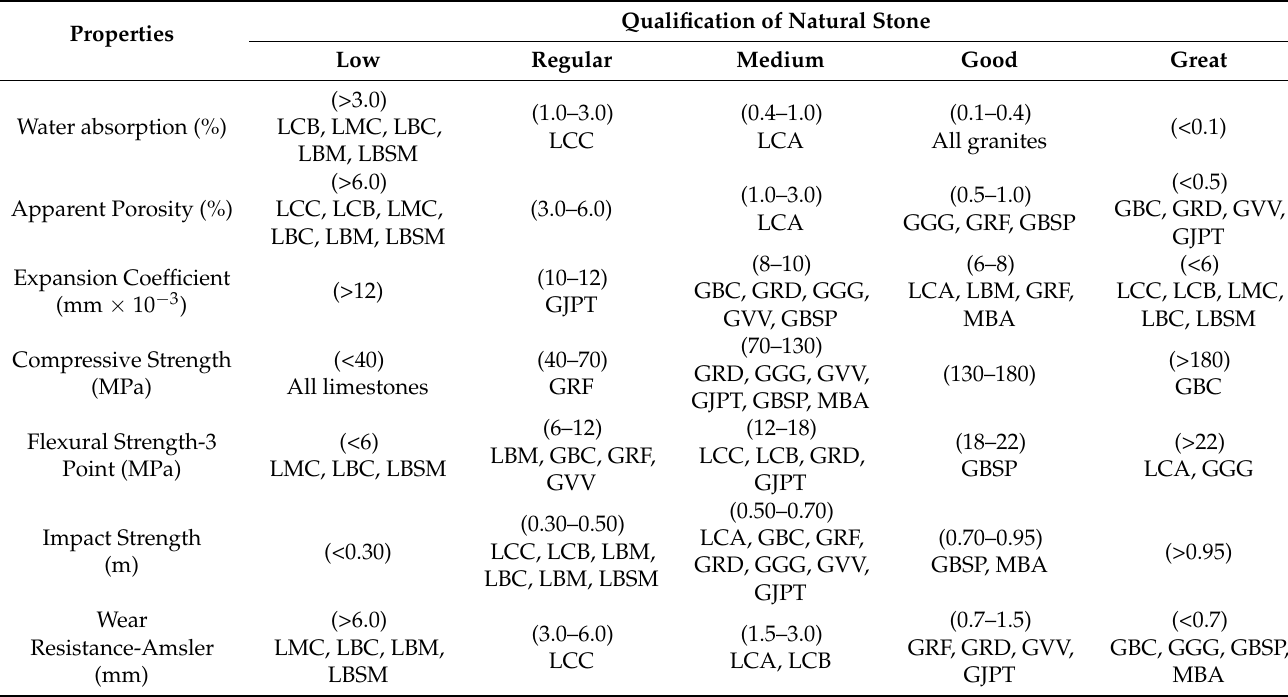
Table 7. Comparative and qualitative analysis of the physical-mechanical properties of limestones, granites, and marble.